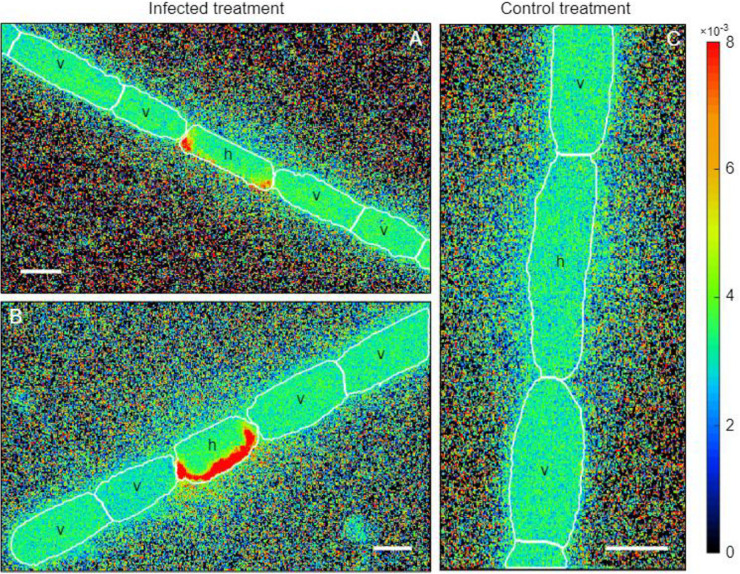
Nanometer-scale secondary ion mass spectrometry (nanoSIMS) micrographs of Aphanizomenon flos-aquae strain 2012/KM1/D3 heterocytes (h) and adjacent vegetative cells (v) in the infected (A,B) and control (C) treatments. The cellular nitrogen distribution is indicated as 12C15N/12C14N ratio.